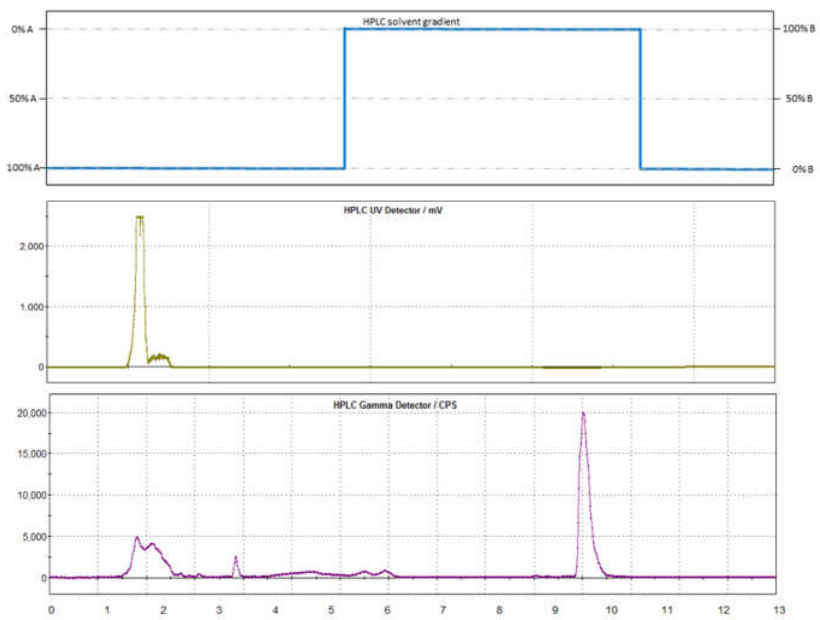
Figure 8. Typical chromatogram of the semi-preparative RP-HPLC purification of the crude mixture: The [ 11 C] m HED elutes after 9.5 min from the C-18 RP column after using a step gradient, as illustrated at the top of the graphic. Solvent A consists of an acetonitrile:water mixture (58:42) and solvent B is a mixture of acetonitrile and acidified water (50:50; 0.004% H 3 PO 4 , conc).